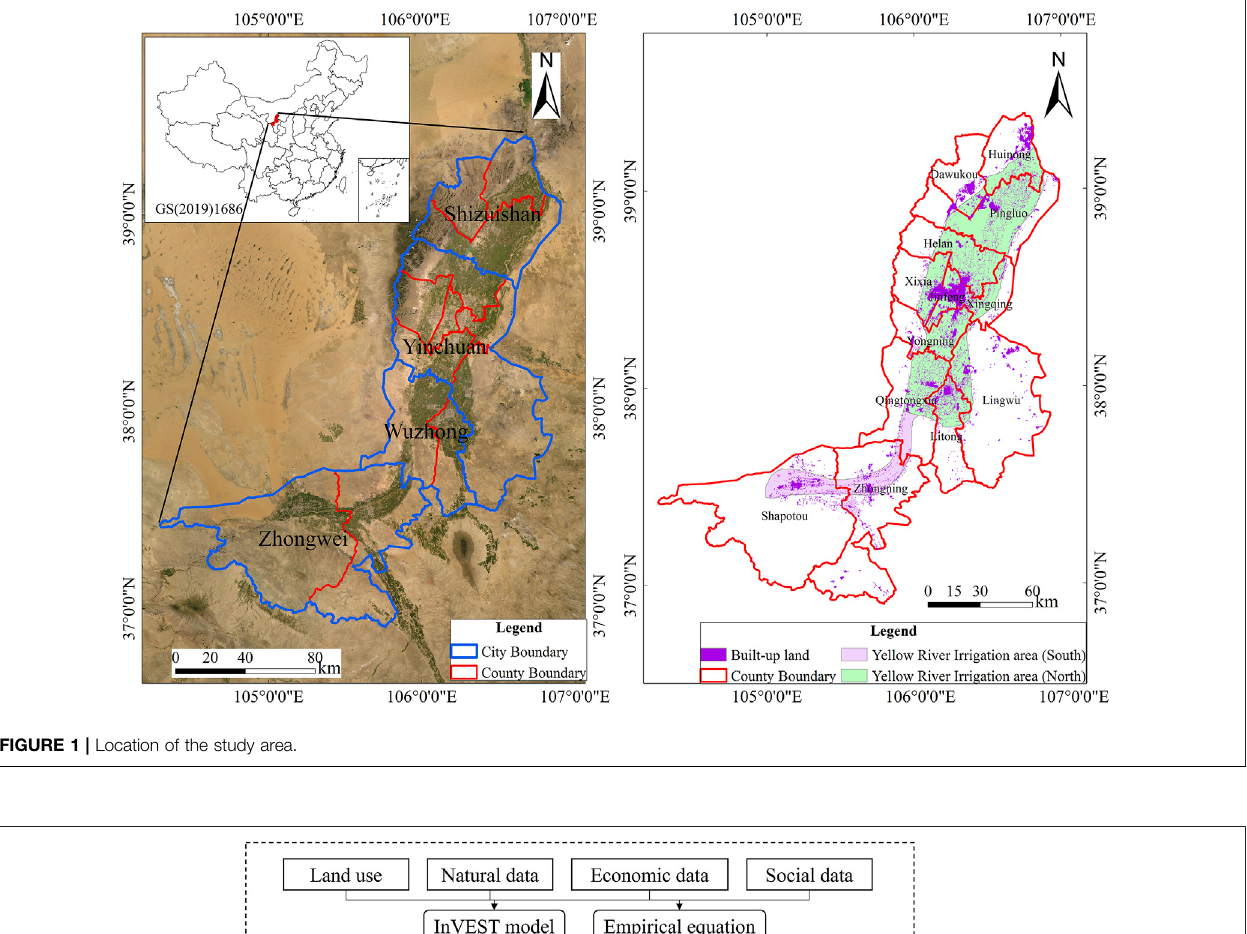
FIGURE 1 | Location of the study area.